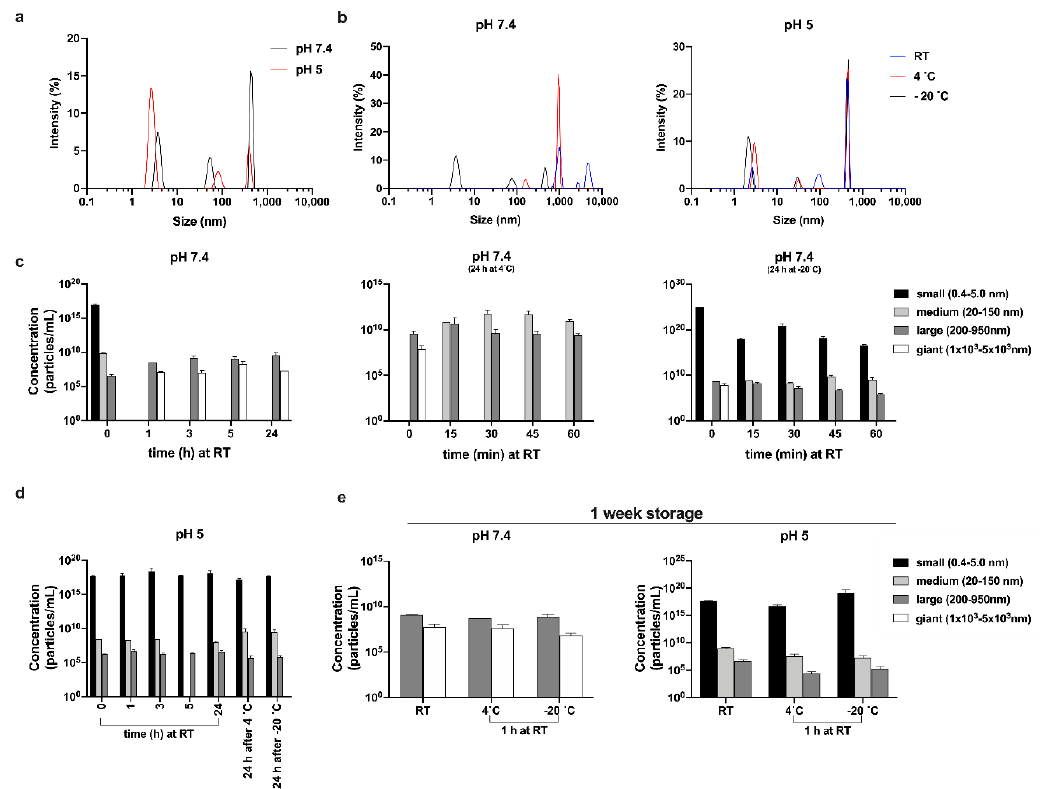
Figure 5. Size of oligomers and their distribution. ( a , b ) Representative size distribution by intensity of 300 µM TCP-25 in 10 mM Tris at pH 7.4 or in 10 mM NaOAc at pH 5.0. Sizes of oligomers at pH 7.4 ( c , e ) and pH 5.0 ( d , e ), and their distributions after storage at RT, 4, or – 20 °C for up to 24 h ( c , d ) or after 1 week of storage ( e ). Oligomers were classified into 4 families: small (0.4–5 nm, black bars), medium (20–150 nm, light gray bars), large (200–950 nm, dark gray bars), and giant (1 × 10 3 – 5 × 10 3 nm, white bars). For each sample, spectra were recorded three times with 11 sub-runs using the multimodal mode. In the graphs, the concentrations of the oligomers belonging to different families are reported as the average ± SD ( n = 2).